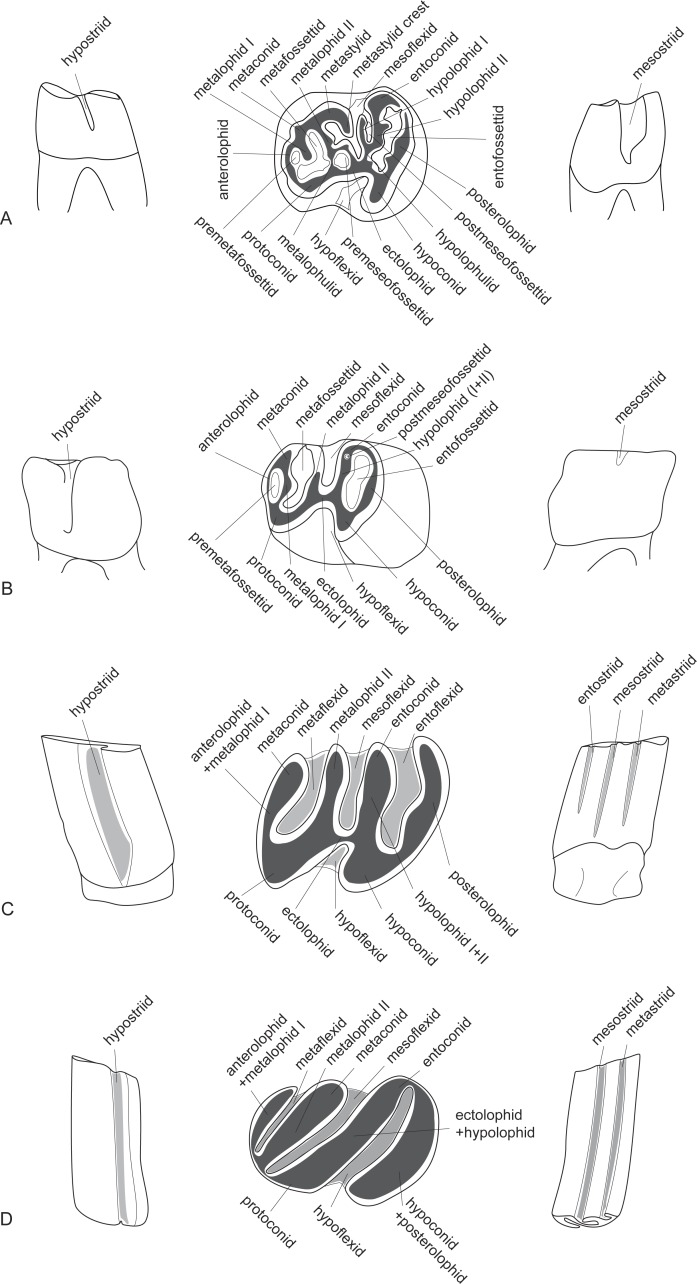
The lower dental structure of the Castoridae after the example of the moderately worn fourth premolars of Propalaeocastor irtyshensis.(A) Propalaeocastor; (B) Steneofiber; (C) Castor; (D) Dipoides. From left to right: lingual view, occlusal view, buccal view. Enamel = white, dentine = dark grey, cement = light grey, -fossettid = -flexid = -striid. Modified from Stirton (1935), Hugueney (1975), Hugueney (1999), Lopatin (2003) and Wu et al. (2004).